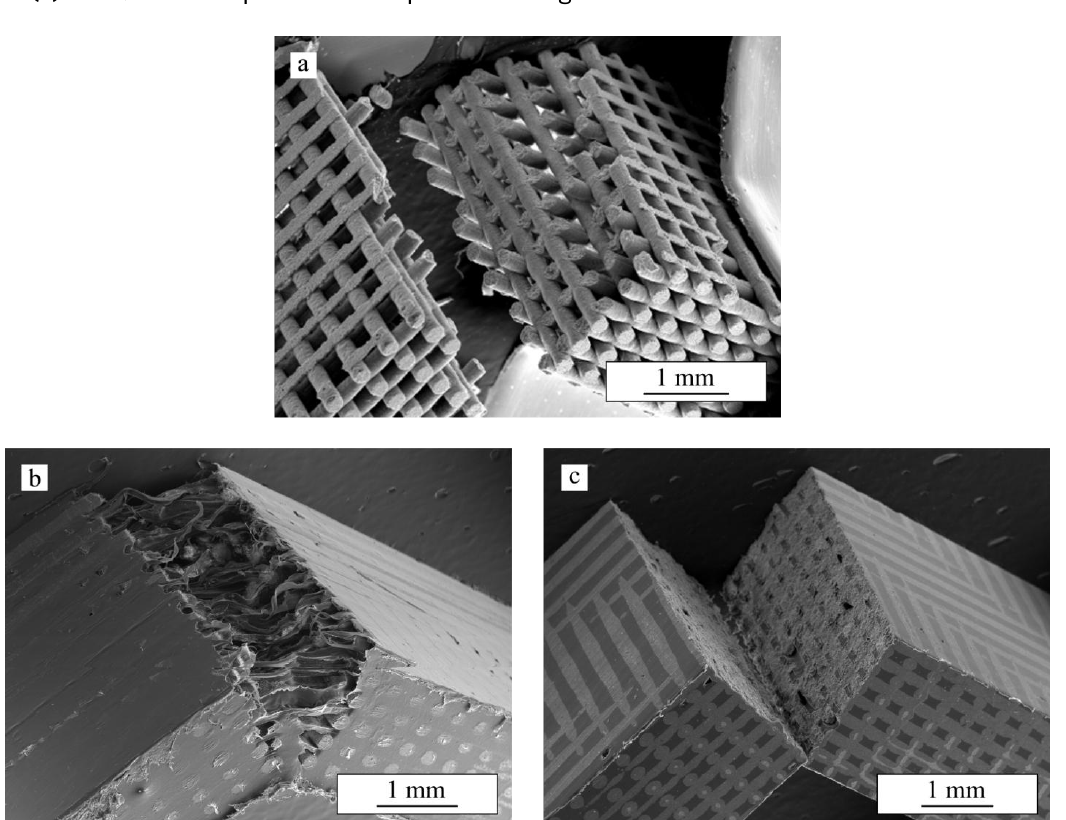
Figure 3. SEM micrograph showing the fracture surface on ( a ) bare TCP; ( b ) TCP/PCL; and ( c ) TCP/PLA samples after a 4-point bending